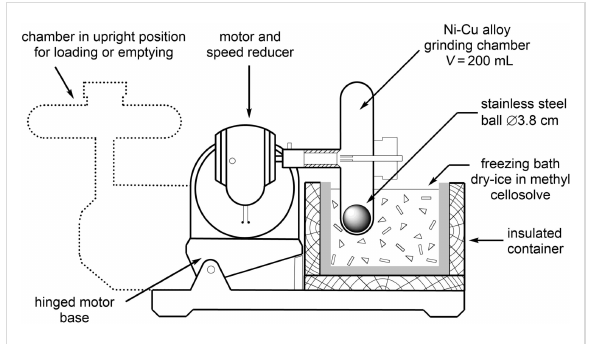
Figure 4: Early low temperature mechanised ball mill as described by Mudd et al. – adapted from reference [78].